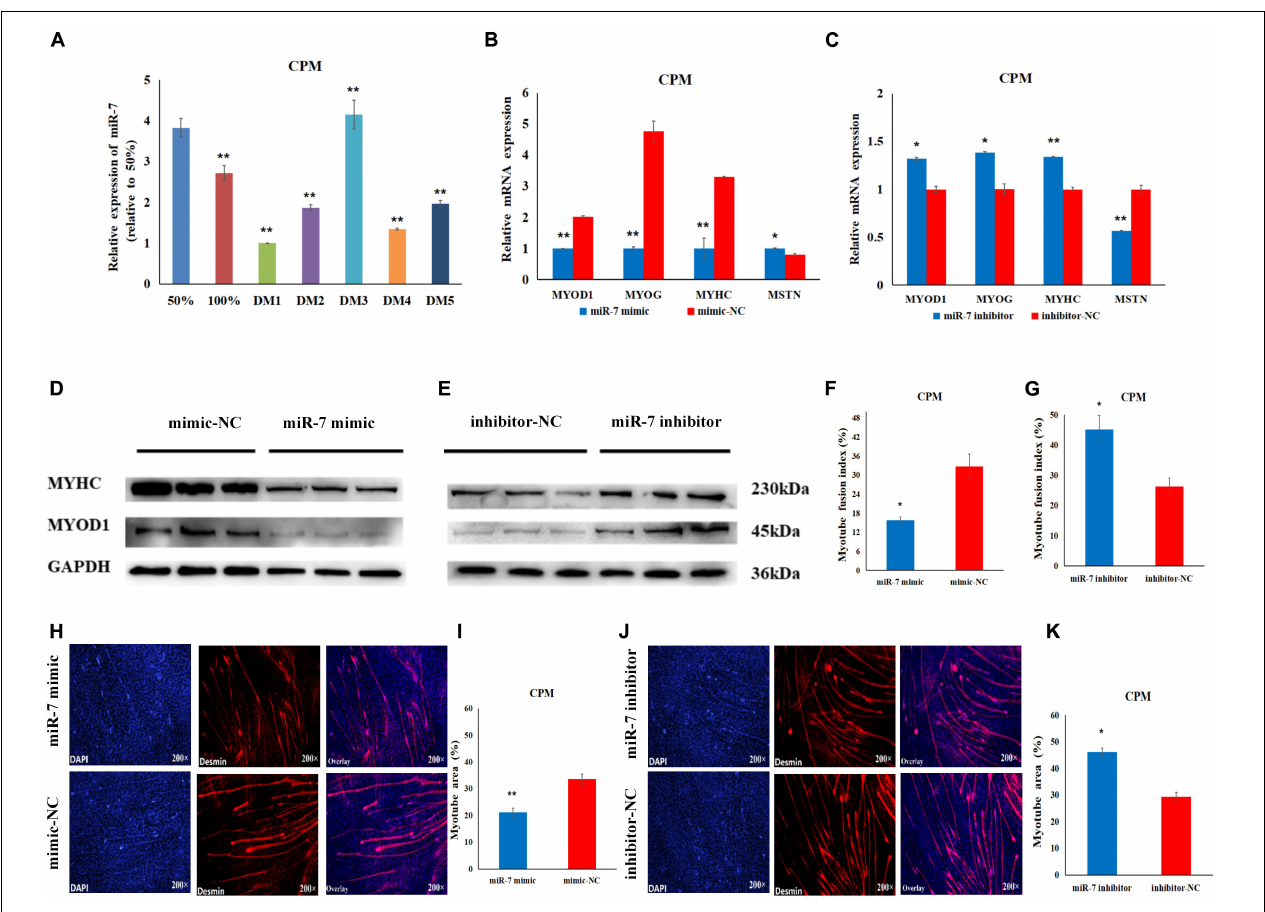
FIGURE 3 | MiR-7 inhibits the differentiation of CPMs. (A) The expression level of miR-7 during the proliferation (50 and 100% confluency) and differentiation of CPMs. DM1, DM2, DM3, DM4, and DM5 represent CPMs which were induced to differentiate for 24, 48, 72, 96, and 120 h, respectively. (B,C) The mRNA expression of MYOD1, MYOG, MYHC and MSTN 48 h after the transfection of miR-7 mimic and inhibitor in CPMs. (D,E) The protein expression of MYHC and MYOD1 72 h after the transfection of miR-7 mimic and inhibitor in CPMs using Western Blot. (F,G) The myotube fusion index (%) of CPMs after the overexpression and inhibition of miR-7. (H,J) Connexin antibody (Desmin) staining of the myoblasts induced differentiation 72 h after transfection of the miR-7 mimic and inhibitor in CPMs. (I,K) The myotube area (%) of CPMs after the overexpression and inhibition of miR-7. Photomicrographs were taken using a 200 × magnification. The results are shown as the mean ± SEM of three independent experiments, * p < 0.05, ** p <